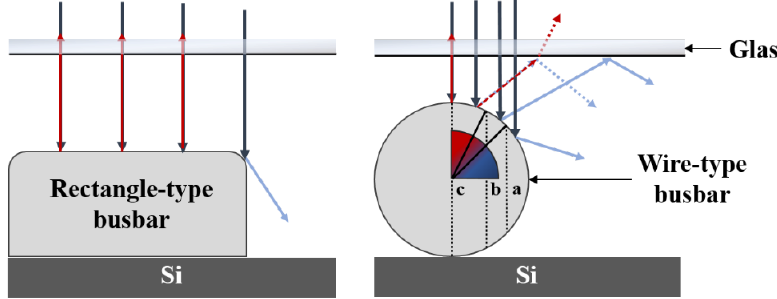
Figure 3. Schematic of the conventional rectangle-type busbar and the wire.